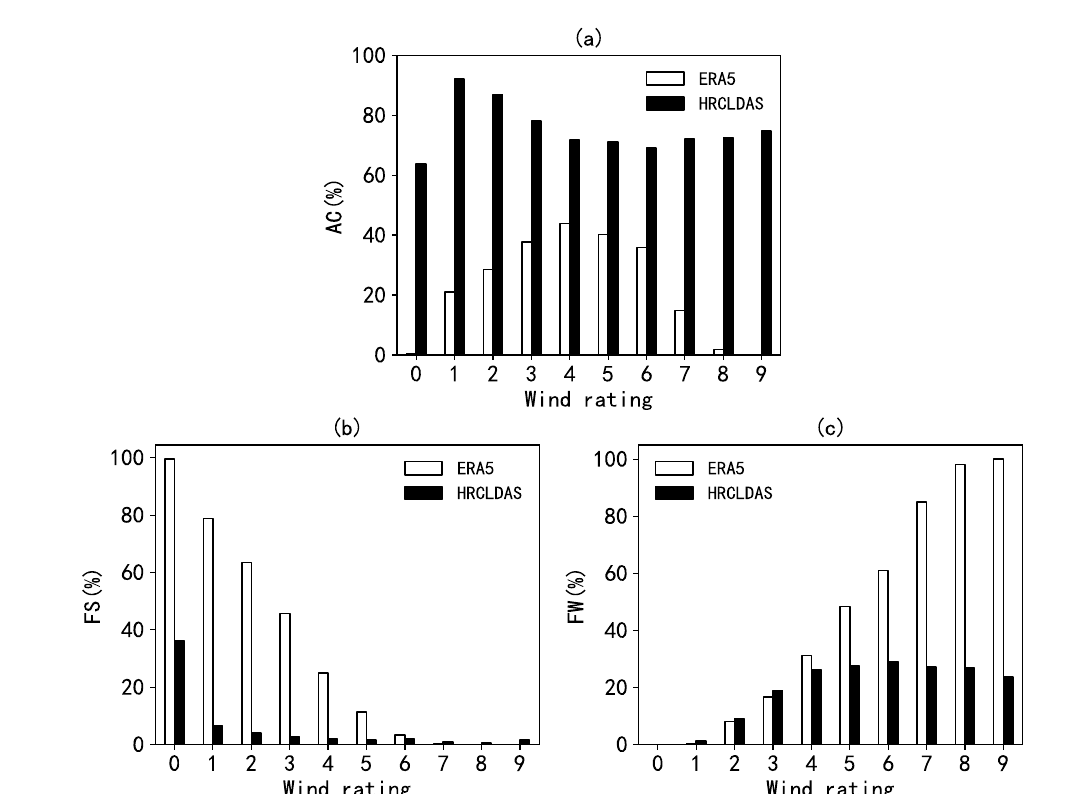
Figure 8. The evaluation indicators of ERA5 and HRCLDAS under various wind levels from April to October 2020: ( a ) accuracy rate; ( b ) strong rate; and ( c ) weak rate.